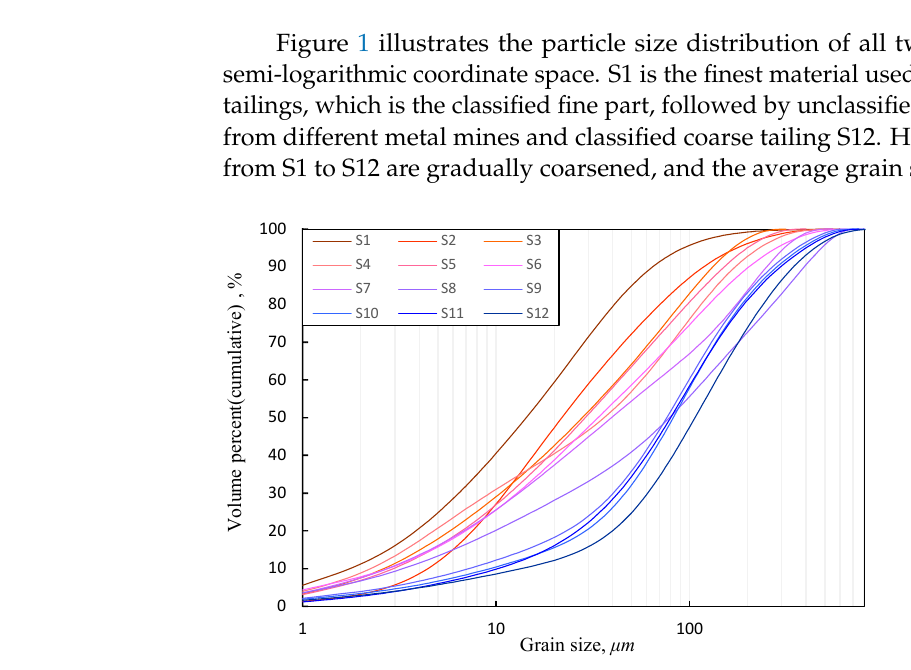
Figure 1. The particle size distribution of twelve different tailings.